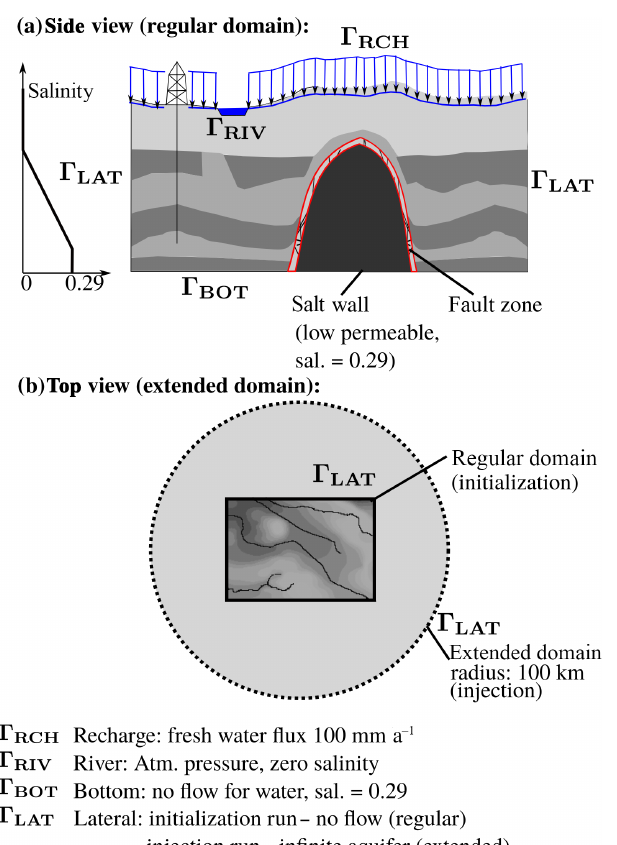
Figure 5. Simplified sketch of the model domain. (a) Boundary and initial conditions of the domain shown through a simplified sketch of the geological model. A linear salinity profile increasing with depth up to a maximum salinity (salt mass fraction) of 0 . 29kgkg − 1 is assumed as an initial condition for the initialization run. Also shown is the position of the fault zone situated at the flank of the salt wall in red. (b) Top view of the domain showing regular do- main boundary used during initialization runs and extended domain boundary used for injection runs.